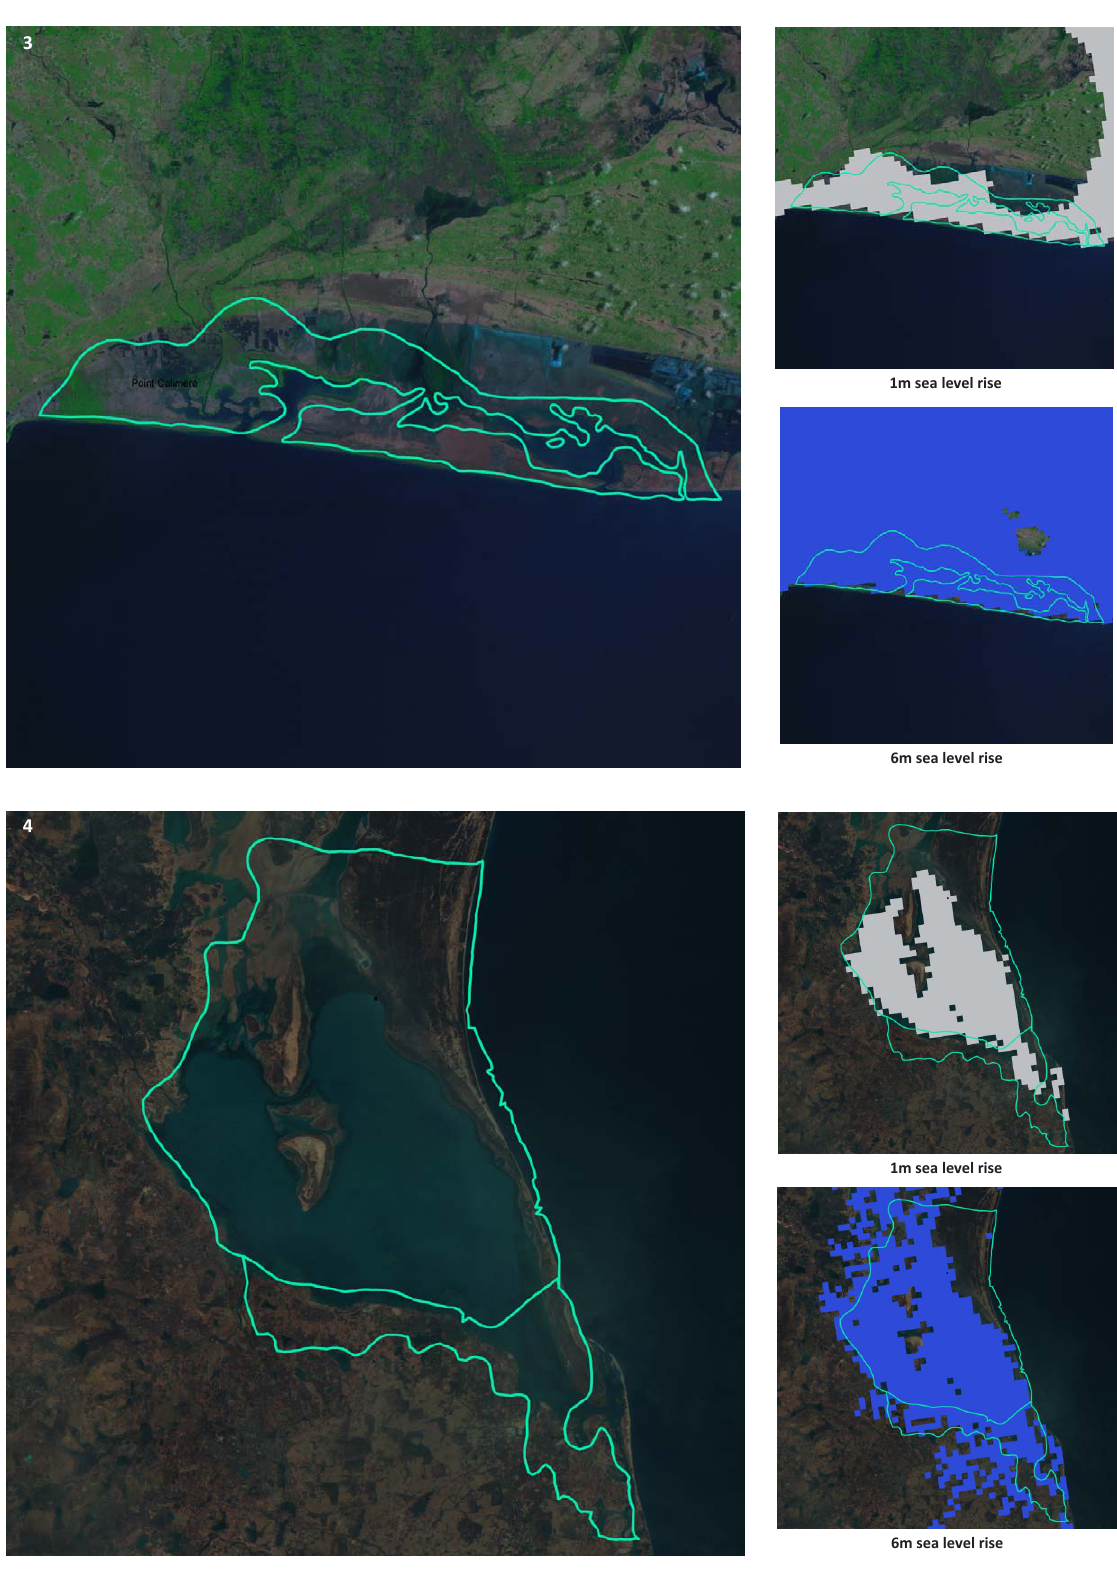
dark blue is water. In the insets, the area inundated by 1 m sea level rise is indicated in white and the area inundated by 6 m sea level rise is shown in light